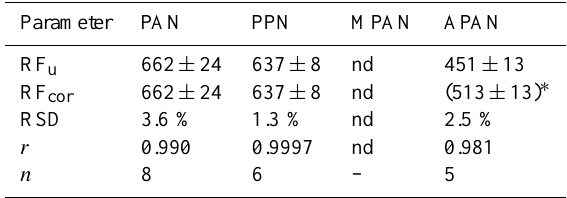
Figure 7. Calibration plots of PAN-GC vs. TD-CRDS during FOS- SILS 2013. ( a , left) Data collected under the initial sampling con- ditions. ( b , right) Data collected after a change in the sample flow rate due to pump failure. The error bars indicate the precision of the measurements ( ± 1 σ) that include the instability of the source output. See Tables 3 and 4 for the linear regression statistics. Table 5. Response factors (in mVsppbv − 1 ) of the PAN-GC for PAN, PPN, and MPAN during FOSSILS 2013, after the switch to a lower flow rate. Abbreviations are as in Table 3.